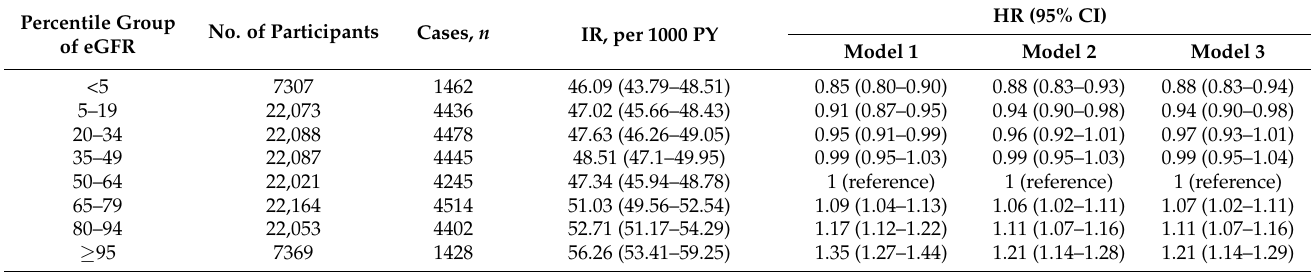
Table 3. Risk of advanced liver fibrosis based on NFS according to the eGFR percentile in patients with NAFLD. Table 2. Incidence and hazard ratios for the development of NAFLD according to eGFR percentile groups.